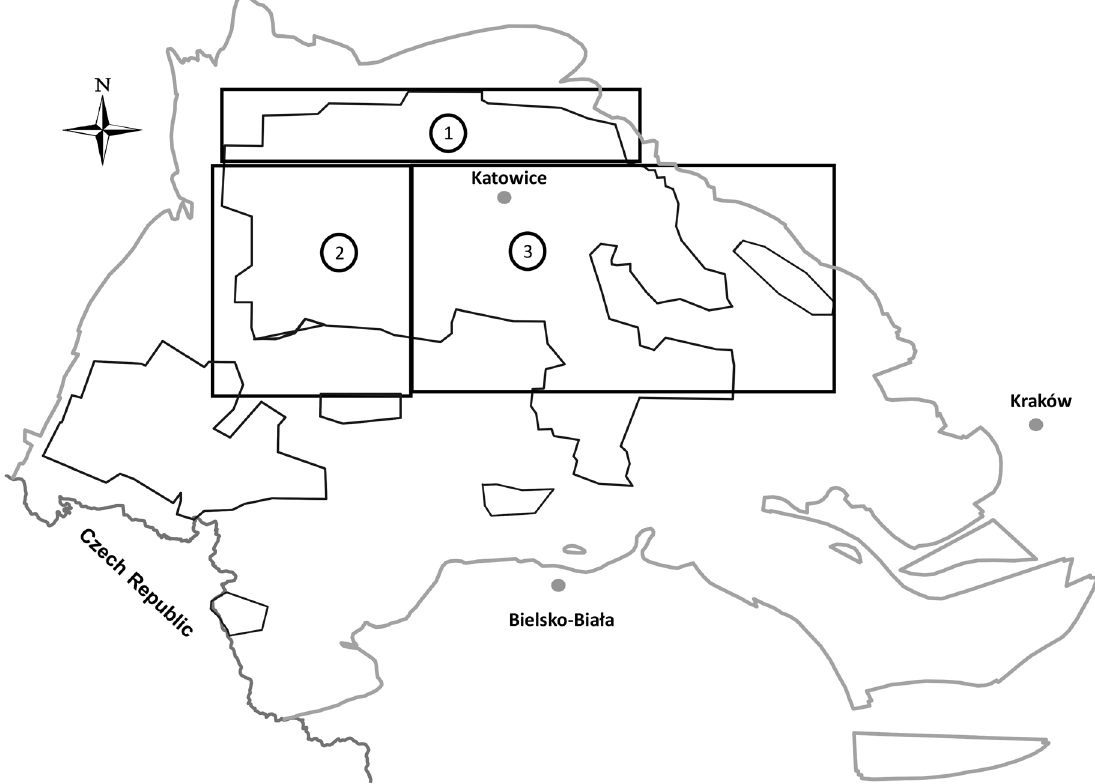
Fig 1. A map of locations of coal sampling sites. Division of the explored area: 1 — north zone (objects nos 1 – 34), 2 — west zone (objects nos 35 – 56), 3 – central zone (objects nos 57 – 132).